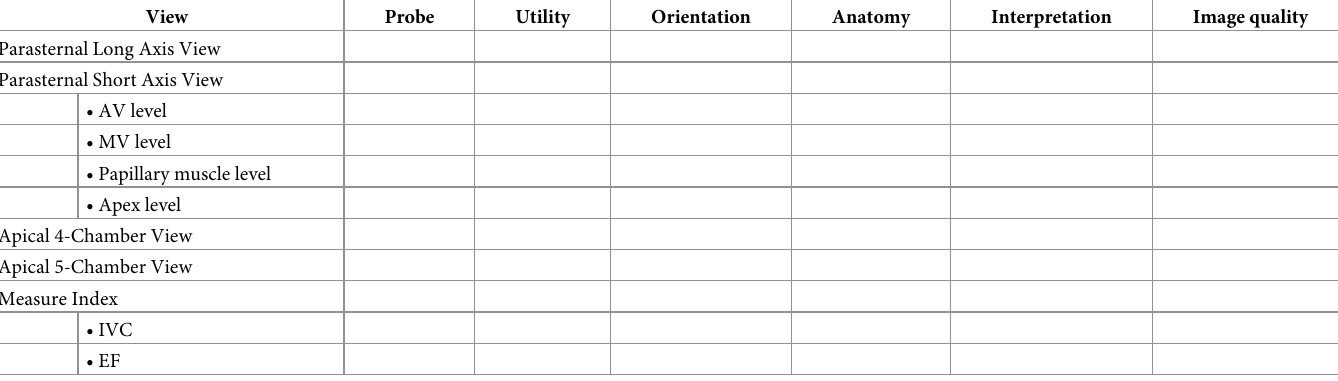
Table 1. Evaluation sheet for performance evaluation of cardiac ultrasound in PoCUS